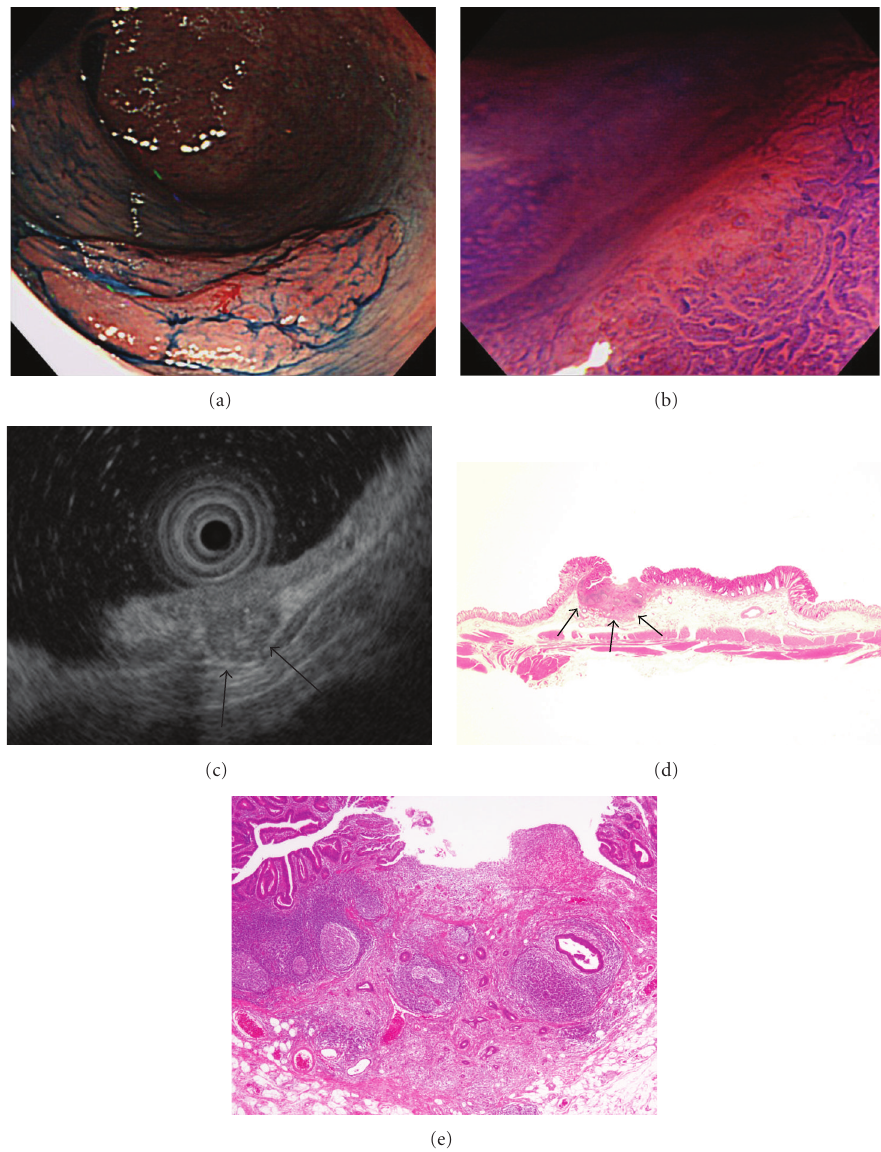
Figure 1: (a) Colonoscopic images after spraying with 0.2% indigo carmine dye, showing a nongranular LST in the rectum. The surface showed mild redness. Extensibility of the tumor on insu ffl ation was relatively good. (b) Magnifying endoscopic images after the application of 0.05% crystal violet stain, showing a type V N pit pattern characterized by an amorphous structure of part of the tumor. (c) EUS images, showing severe narrowing of the third layer in part of the tumor (arrow). Cancer with deep submucosal invasion was diagnosed. (d) and (e) Histopathological findings of the surgically resected specimen. (d) The longest diameter of the tumor was 20 mm. Although most of the tumor was confined to the mucosa, part of the lesion invaded the middle layer of the submucosa (arrow). The diagnosis was a well- di ff erentiated tubular adenocarcinoma. (e) The intramucosal part of the tumor had become detached at the site of submucosal